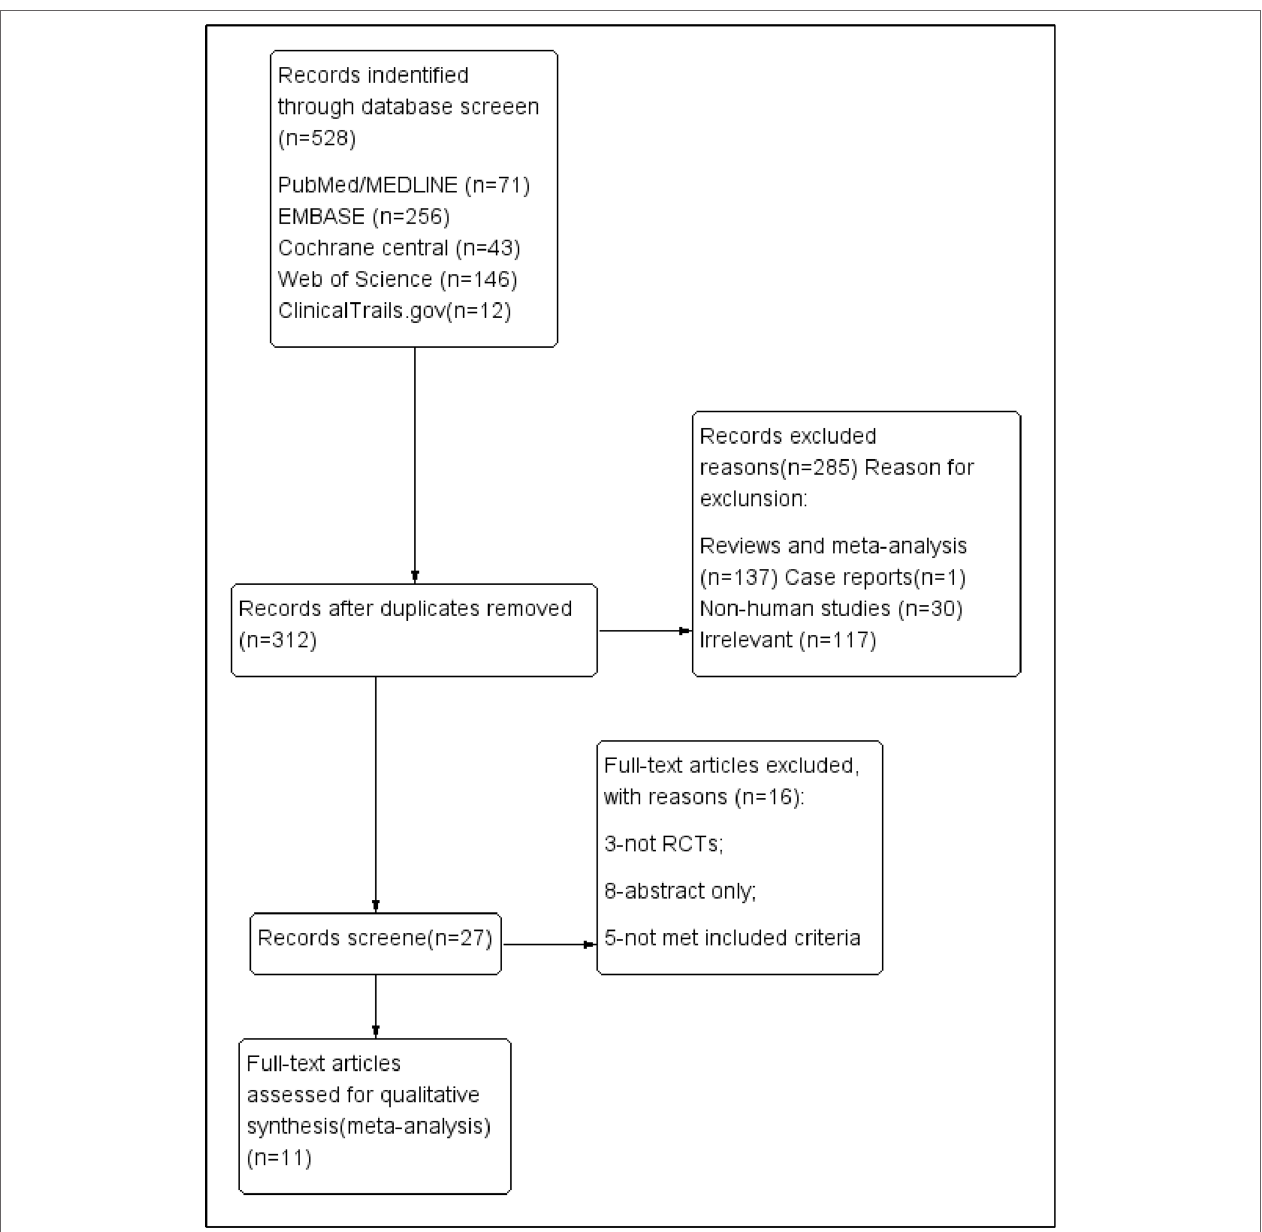
FIGURE 1 | PRISMA flow diagram of the screening and selection process used in the